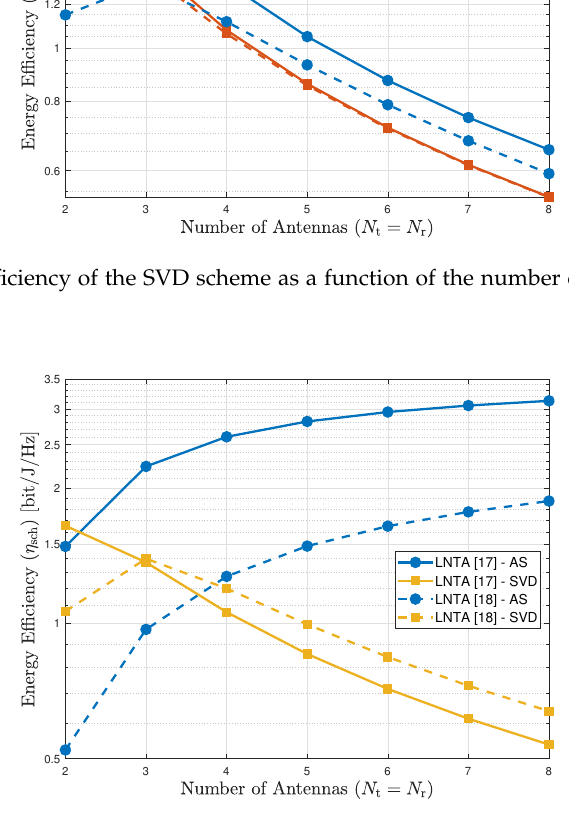
Figure 7. Energy efficiency of the AS and SVD schemes as a function of the number of antennas for the LNTA designs in [17,18], for d = 400